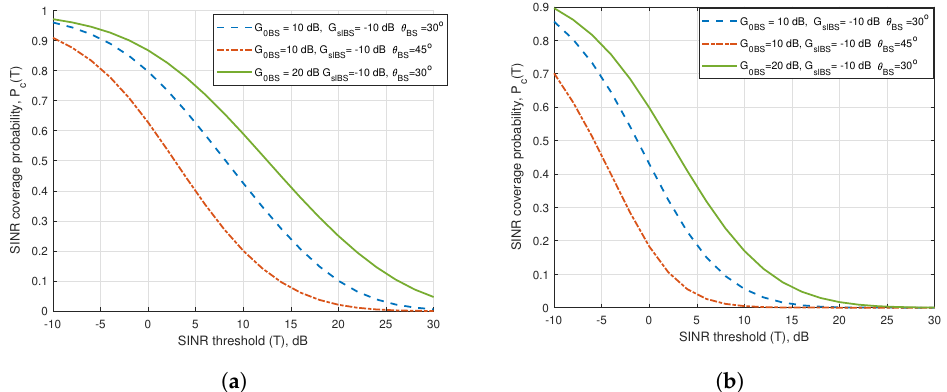
Figure 6. SINR coverage probability P c ( T ) vs. SINR threshold (T) for different BS antenna parameters at r c = 100 m. ( a ) obstacle scaling factor ζ = 1 ( b ) obstacle scaling factor ζ = 2.